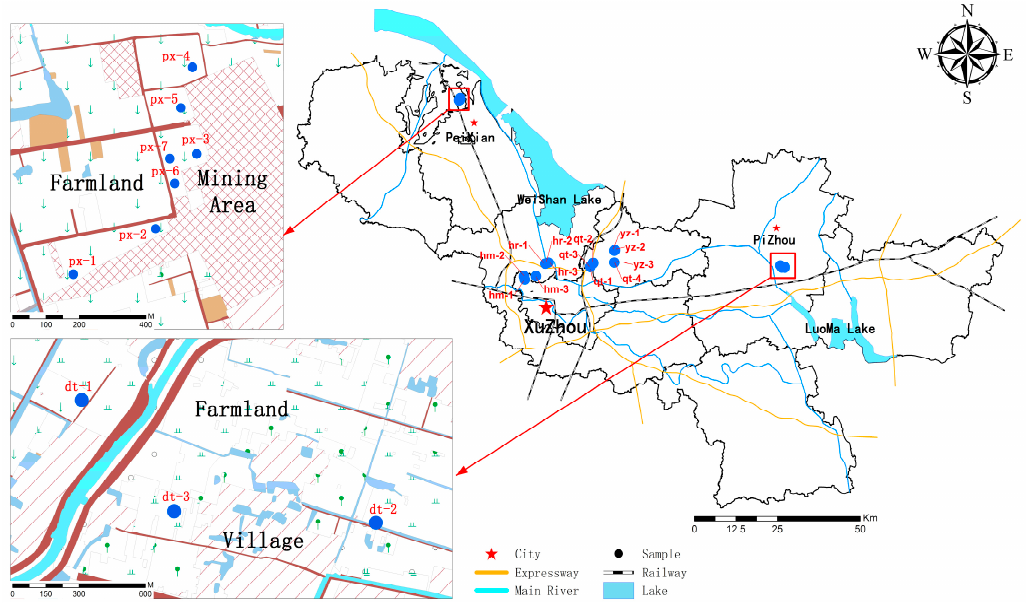
Figure 1. Map showing the sampling locations in Xuzhou city.